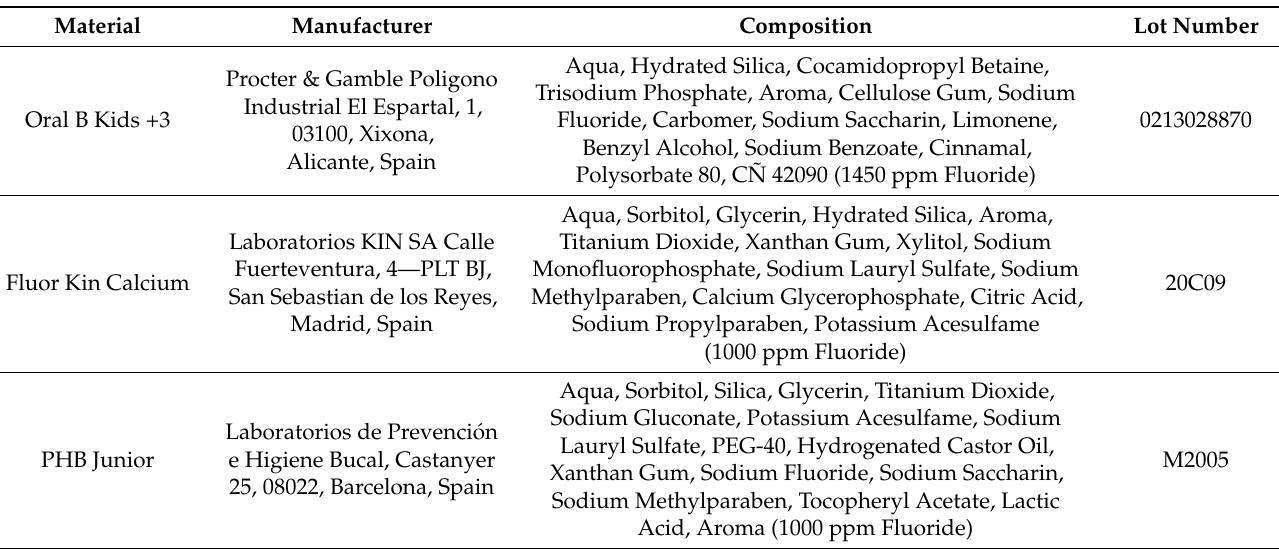
Table 1. Children’s toothpastes